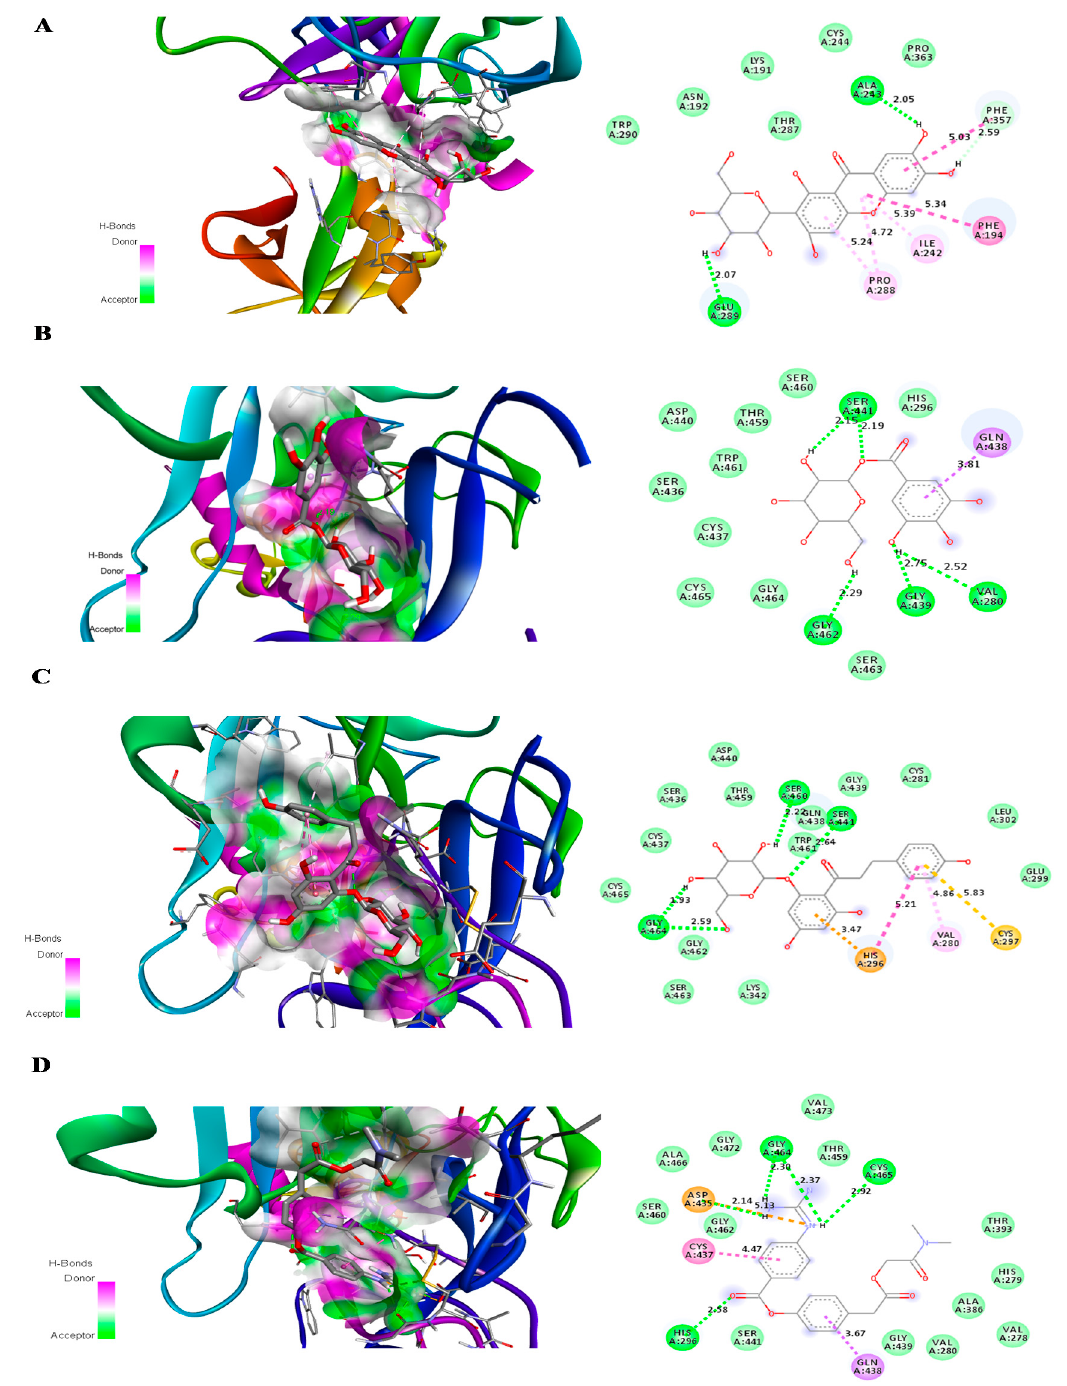
Figure 3. Predicted 3D structure of the ligand–protein interaction at the left side and 2D animated pose showing interaction. ( A ) TMPRSS2 protein of SARS-CoV-2 with mangiferin. ( B ) TMPRSS2 protein of SARS-CoV-2 with glucogallin. ( C ) TMPRSS2 protein of SARS-CoV-2 with phlorizin. ( D ) TMPRSS2 protein of SARS-CoV-2 with camostat mesylate.